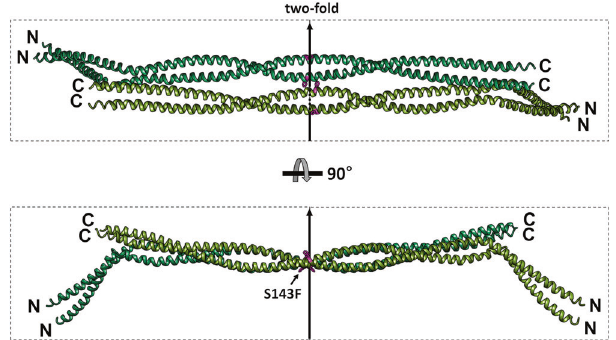
Fig. 2 The tetrameric unit of the S143F mutant lamin 300 fragments. The A11 tetramer structure was generated by applying crystallographic twofold symmetry to the asymmetric unit. The top and side views of the tetramer, consisting of two antiparallel coiled-coil dimers, are colored separately. The twofold symmetry axis is represented by a black arrow. The Phe143 residues are colored magenta in stick representation.